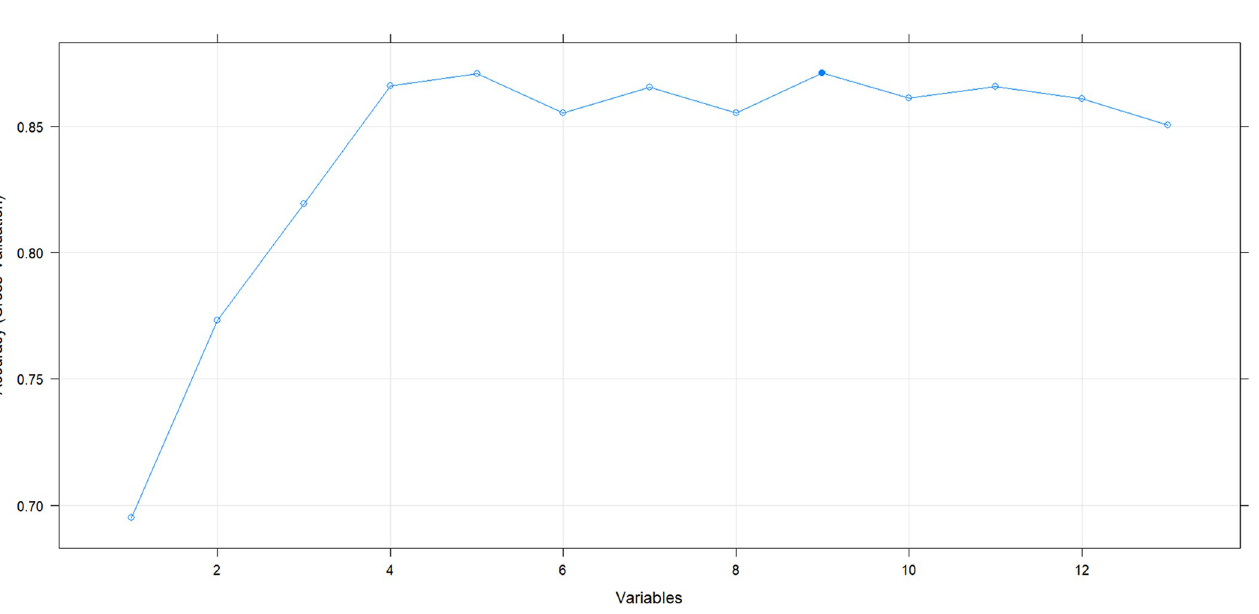
PLOS ONE | https://doi.org/10.1371/journal.pone.0227419 January 15,